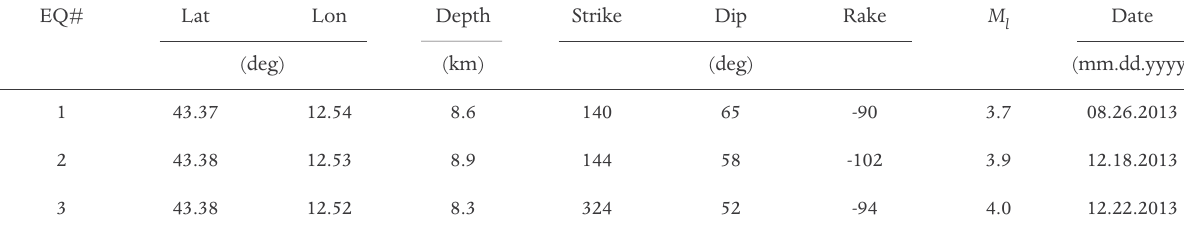
≥ 3.7 earthquakes occurring in Pietralunga area in the period between January 1, 2011 and December 31, 2013. Table 1. Parameters of the M l The distributions of the earthquakes are given in Figure 1.